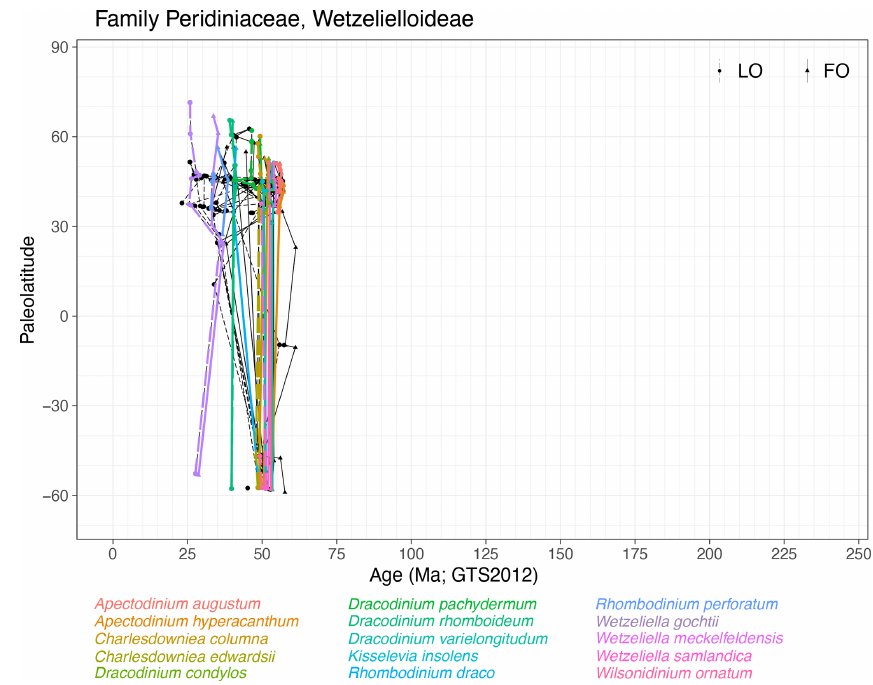
Figure 23. Same as Fig. 5 but for the family Peridiniaceae, subfamily Wetzelielloideae.